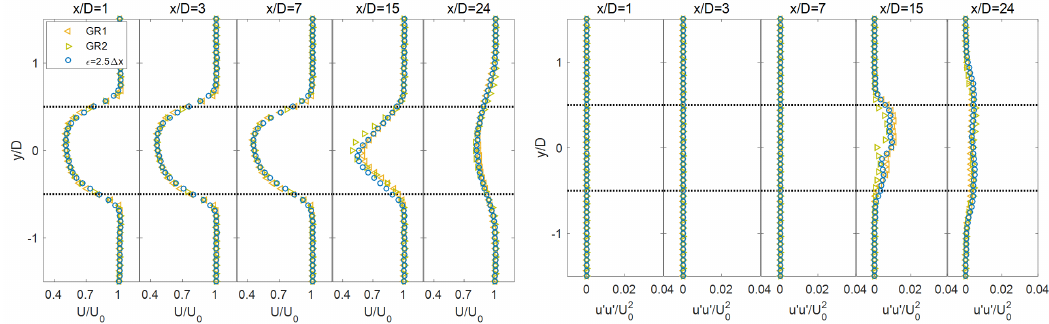
Figure A1. Lateral profiles of the normalized streamwise velocity ( U / U 0 ) ( left ) and streamwise velocity variance ( u (cid:48) u (cid:48) / U 2 ) ( right ) through the hub level at x / D = 1,3,7,15,24 downwind of the turbine 0 obtained from the LSDD model with two different (cid:101) values and two different spatial